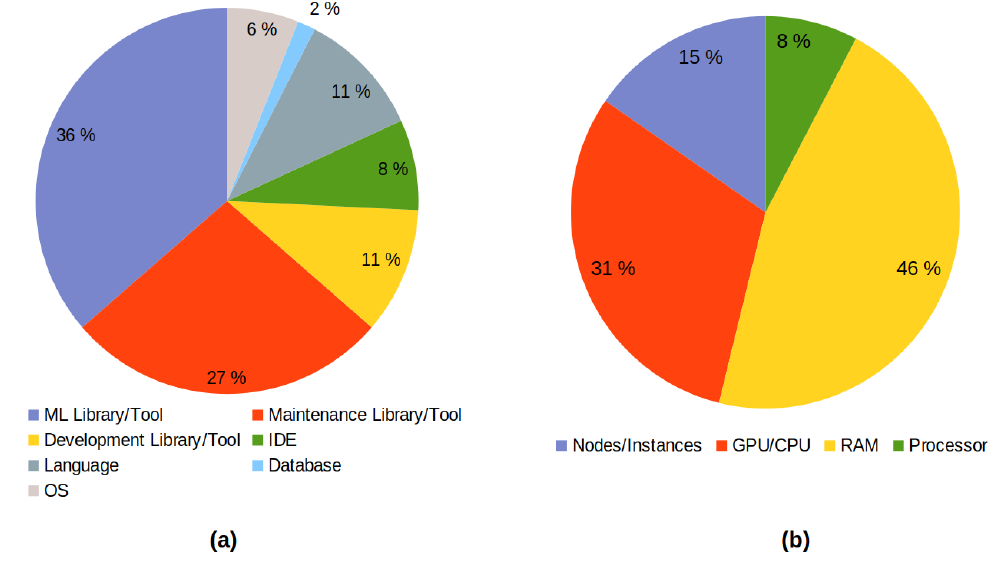
Figure 16. ( a ) Types of detailed software configurations; ( b ) types of hardware configurations